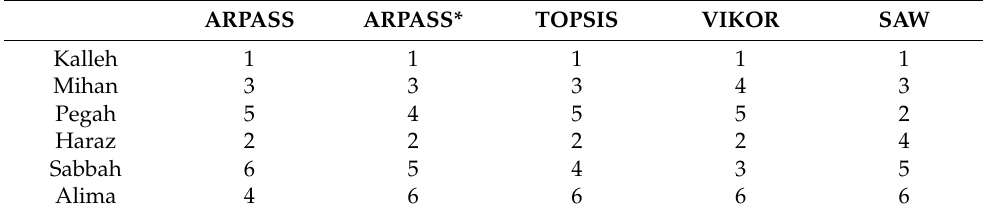
Table 21. The ranking results of the first six suppliers.